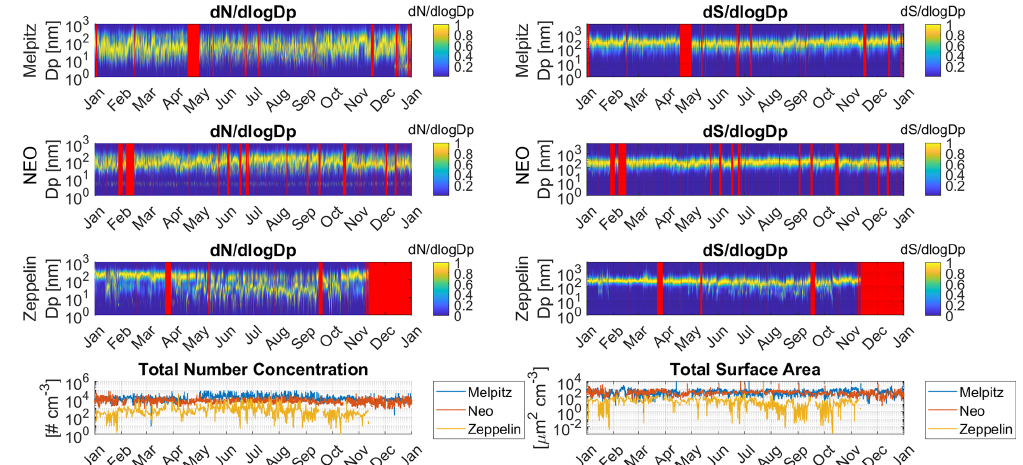
Figure 3. Seasonal development of the initial PNSD normalized to the maximum in the bin with the highest concentration (left column) and initial surface size distribution normalized to the maximum in the bin with the largest surface area (right column). Melpitz in 2008 (top row), NEO in 2010 (second row) and Zeppelin in 2012 (third row). Three modal fits calculated from measurements at each station. The bottom row contains the total number concentration (left) and total surface area